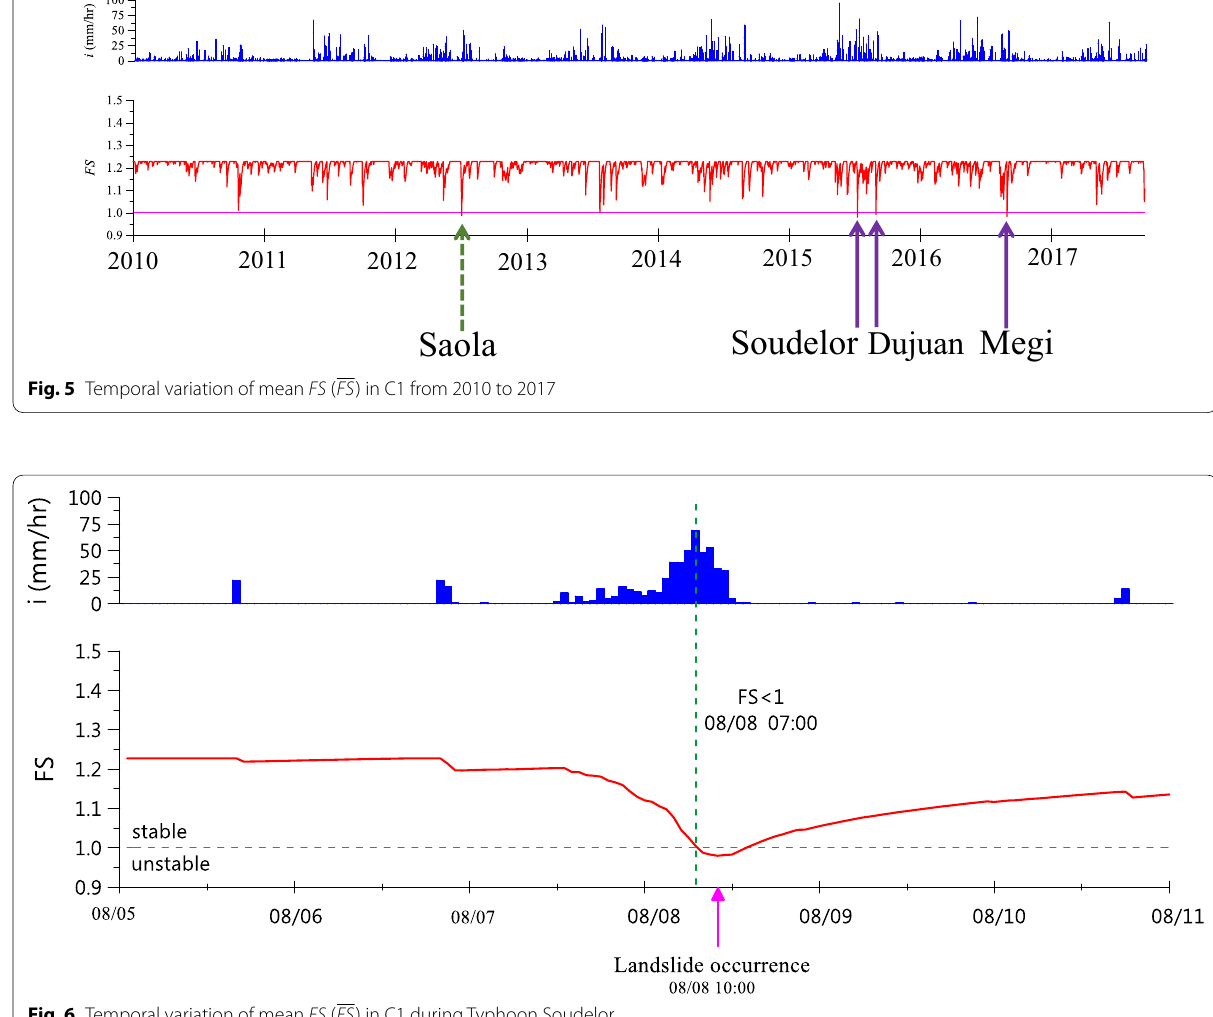
Fig. 6 Temporal variation of mean FS ( FS ) in C1 during Typhoon